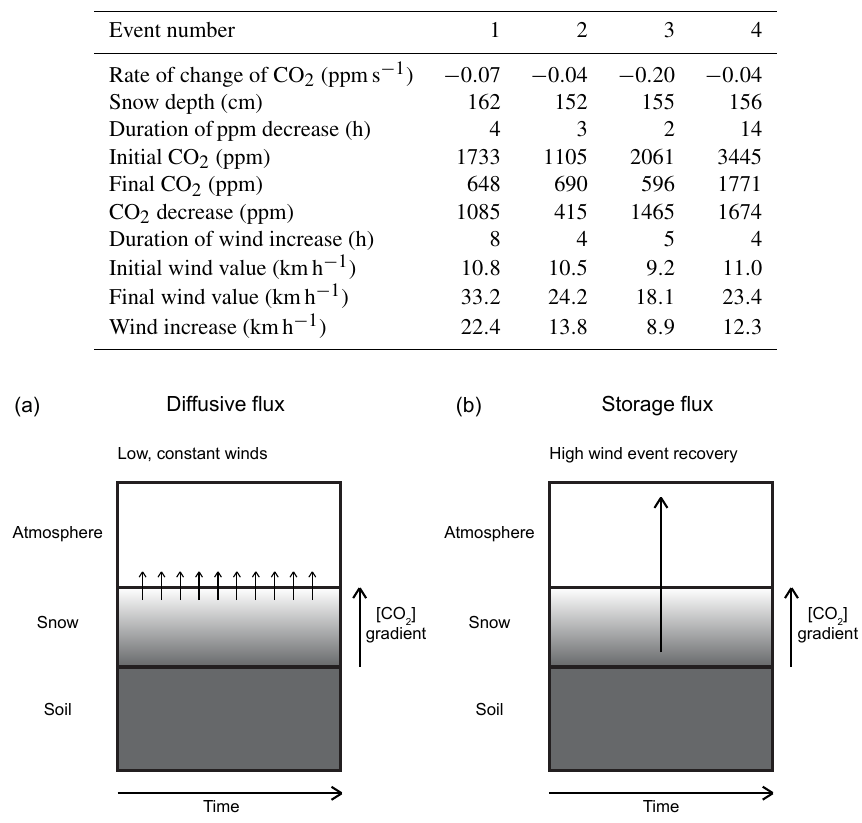
Figure 7. Conceptual diagram of diffusive versus storage flux. (a) Diffusive flux through a snowpack, with CO 2 originating from soils and consistently passing through a diffusive medium into the atmosphere as a result of a concentration gradient. Small arrows indicate low levels of diffusive flux that are prevalent and constant through time. (b) Storage flux through a snowpack, with CO 2 originating from soils, pooling in a diffusive medium, and then released to the atmosphere at a higher rate (than diffusive flux) following a high wind event, which has ventilated the top of the diffusive medium and steepened the concentration gradient. The larger arrow indicates the higher rate and lower frequency of storage flux out of snowpacks when compared with diffusive